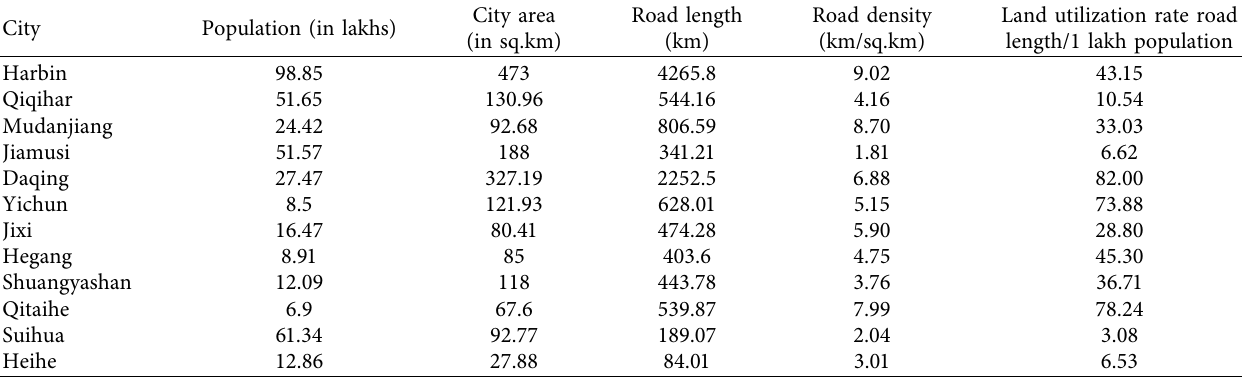
Table 1: Land utilization of cities in Heilongjiang